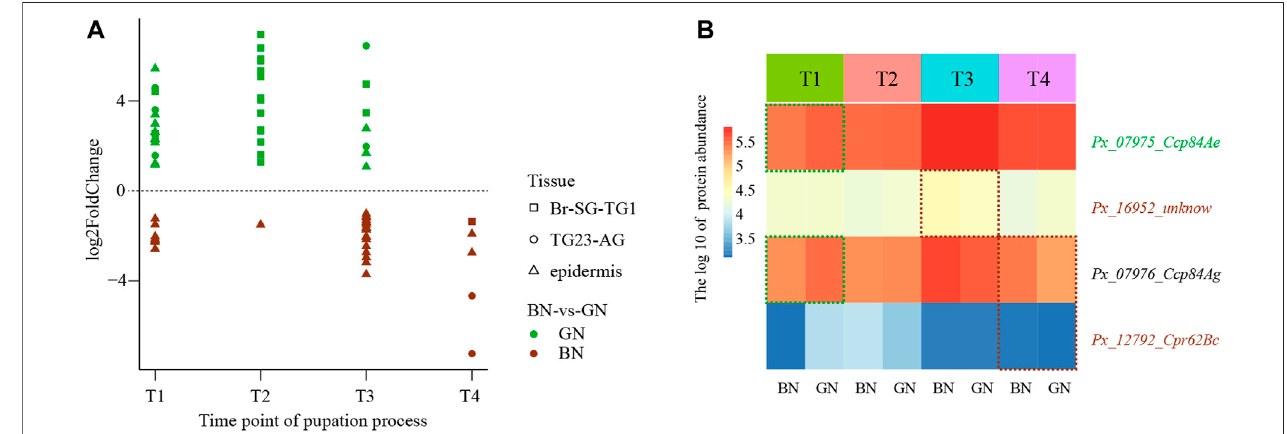
FIGURE6 | The expression pro fi les of cuticular proteins under green and brown conditions at transcriptional level or protein level. (A) The scatter plot ofdifferential expression genes (DEGs) at transcriptional level. (B) Heatmap of the different abundance proteins (DAPs). Full information of tissues and periods refers to Figure 1